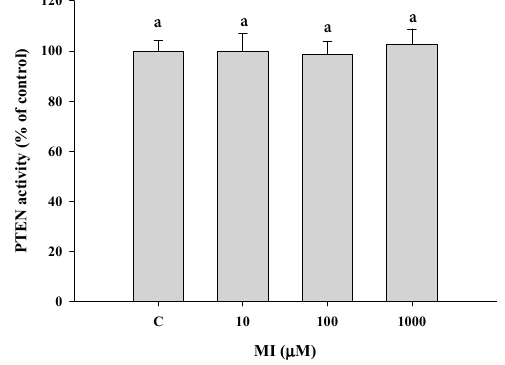
Figure 8. Effects of MI on the PTEN activity in vitro. The PTEN enzyme was incubated with different concentrations of MI (0–1000 μ M). The PTEN activity was detected by a commercial Malachite Green Assay Kit as described in Methods. The relative PTEN activities are expressed as the mean ± SD (n = 3 independent experiments); Values not sharing a common letter are significantly different ( p < 0.05).